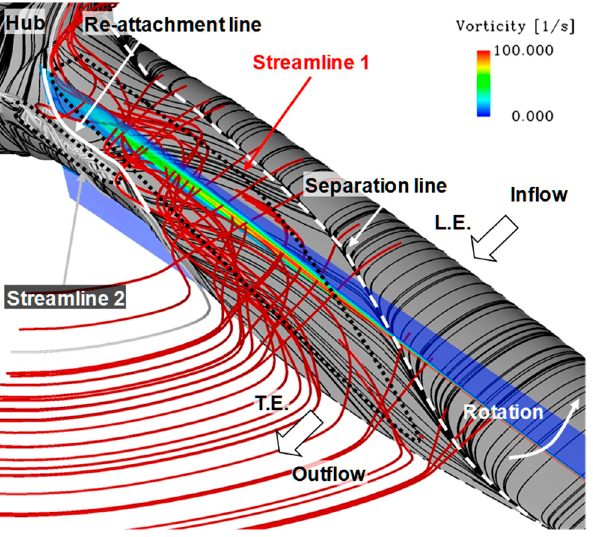
Figure 6. Three-dimensional flow structure at the rotor hub.